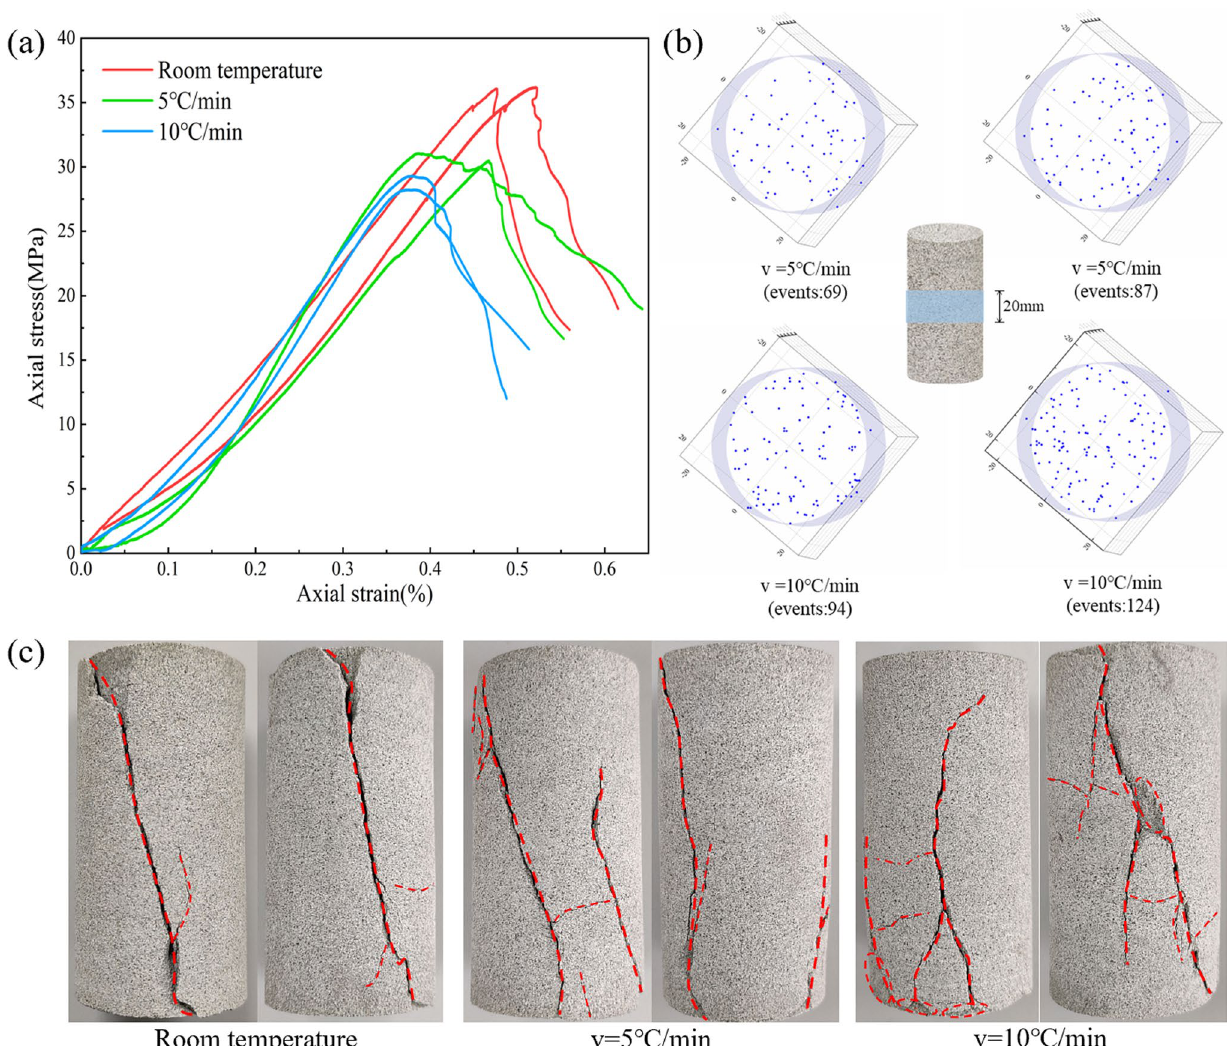
Fig. 3 Experimental results a Stress–strain curves b AE event distribution c Failure